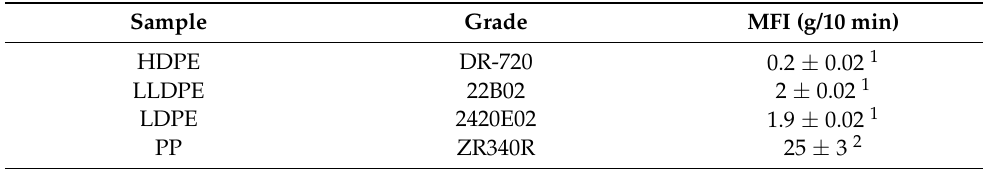
Table 1. Mass flow index of commercial grade